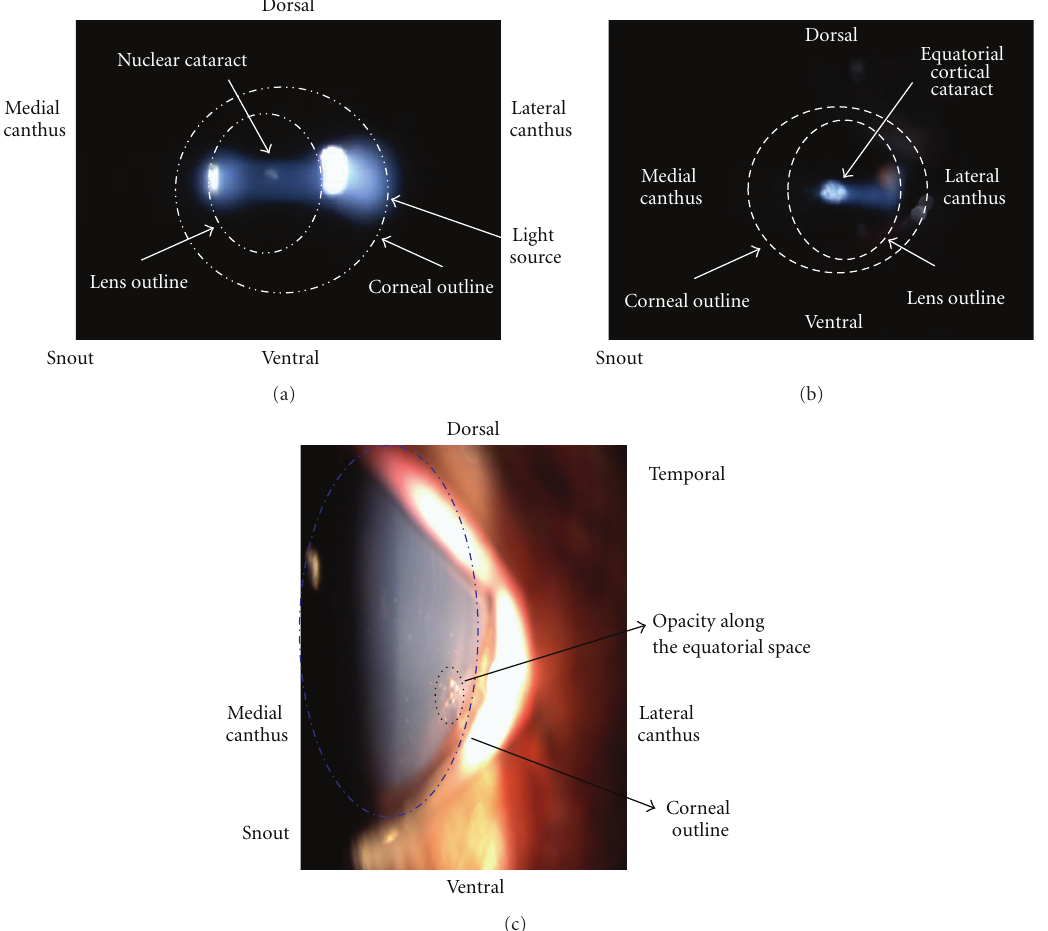
Figure 2: (a) Nuclear cataract found in the 0Gy animal at day 205. At day 270, no significant worsening was noted. (b) and (c) Cortical lens changes seen in the 90 Gy animal at day 270 by slit lamp examination and by external ocular